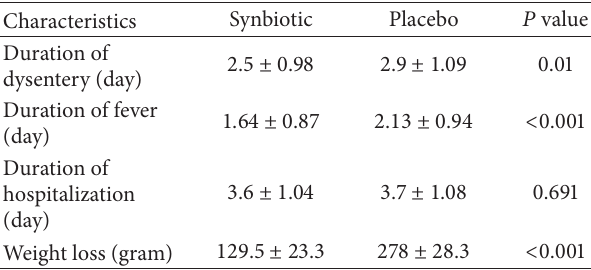
Table 2: Mean and standard deviation of patient characteristics during the